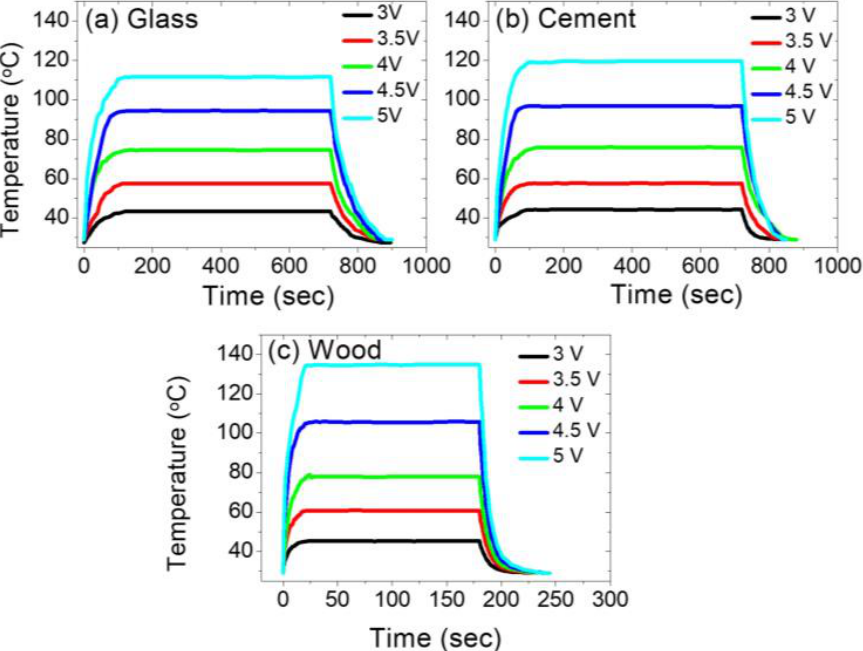
Figure 7. Temperature response versus time of ( a ) AgNWs/glass; ( b ) AgNWs/cement; and ( c ) AgNWs/wood heaters, respectively, at five bias voltages: 3, 3.5, 4, 4.5, and 5 V. As shown in Figure 7a, the AgNW heater based on the glass substrate with a bias voltage of 5 V reached a steady temperature of 112 ◦ C, while the saturation temperatures at bias voltages of 4.5, 4, 3.5, and 3 V were 94.5, 74.6, 57, and 43 ◦ C, respectively. Figure 7b shows that the steady temperatures of the cement heater-based AgNWs are 120, 97, 76, 57.8, and 44 ◦ C at bias voltages of 5, 4.5, 4, 3.5, and 3 V, respectively. A sample of